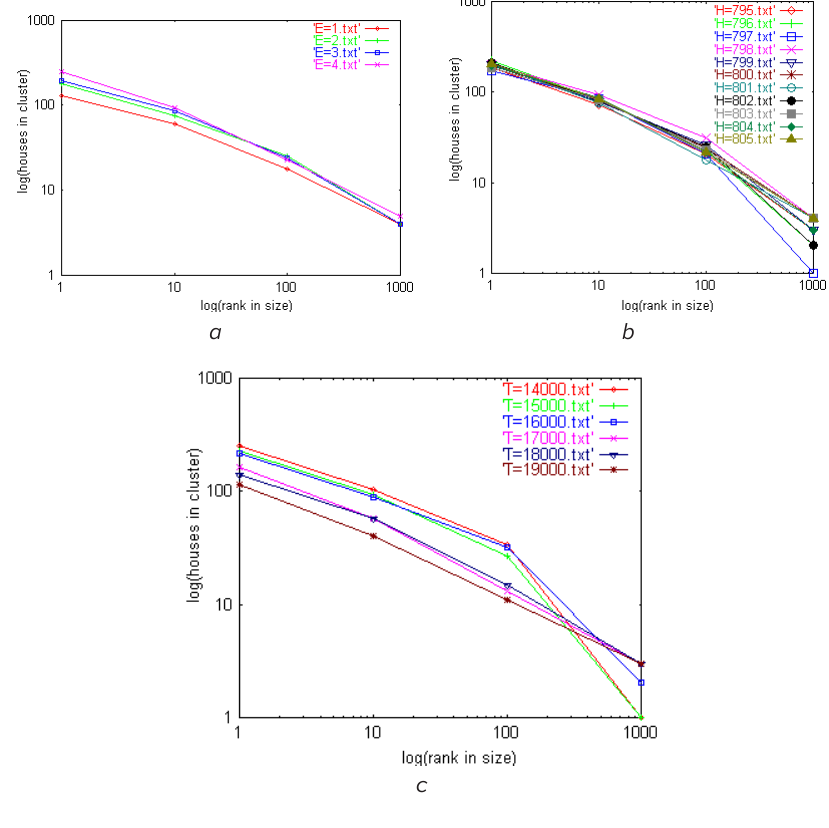
Figure 3. Graphical results of Tables